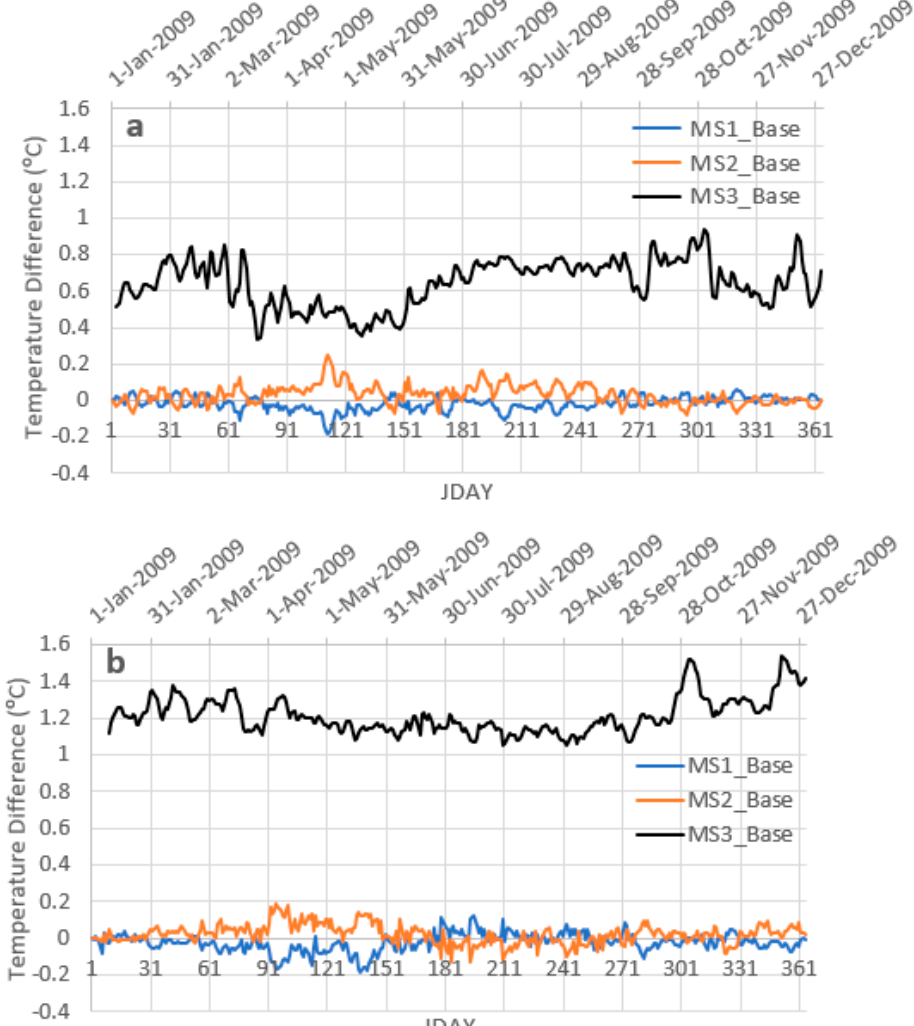
Figure 8. Model differences of water temperatures at (a) Baeji, (b) Baghdad for the base model (existing conditions), MS1: increasing upstream flow, MS2: decreasing upstream flow, and MS3: impacts of climate change.